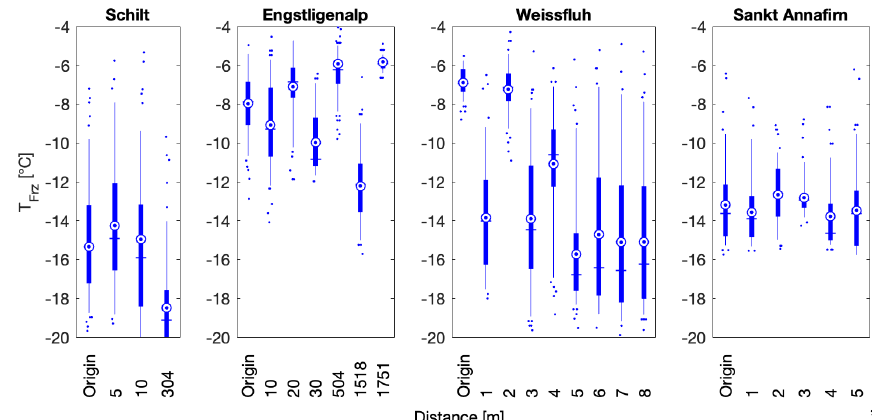
Figure 7. Spatial distribution of freezing temperatures of snow samples collected at four different flat sites, at Schilt on 24 February 2018, at Engstligenalp on 14 April 2018, at Weissfluh on 15 April 2018 and at Sankt Annafirn on 22 April 2018. Weissfluh and Sankt Annafirn are particularly striking since the snow samples collected at these sites show heterogeneity within 1m distances. All the samples at the same location were collected on the same day. In the boxplots, the blue vertical line shows the median and is equal to T 50 , the mean is shown as a blue circle with a concentric dot and the box ranges from the 25th to the 75th percentiles, and the whiskers extend from the 5th to the 95th percentiles.